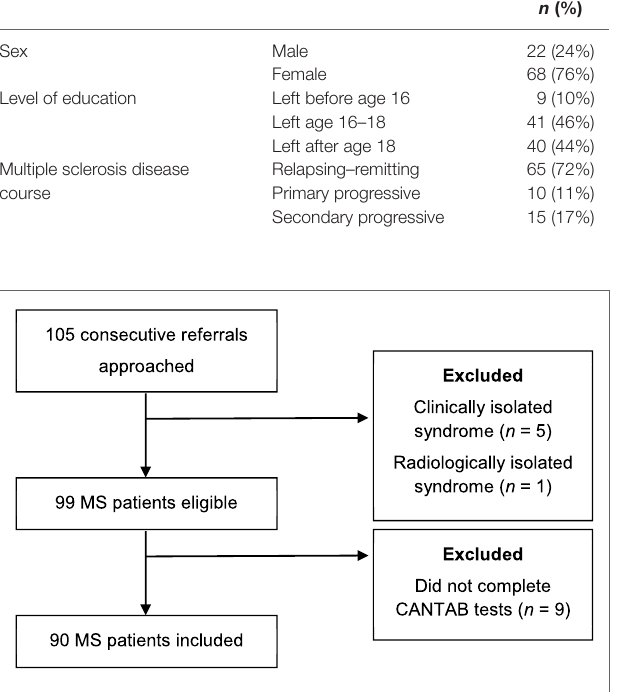
FigUre 1 | Patient recruitment flowchart.